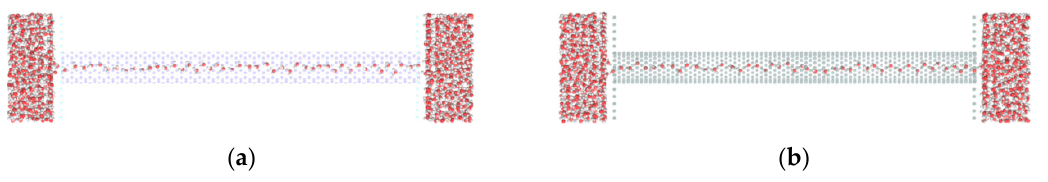
Figure 1. Schematic of molecular dynamics simulation setup: ( a ) boron nitride nanotube (BNNT) and ( b ) carbon nanotube (CNT).